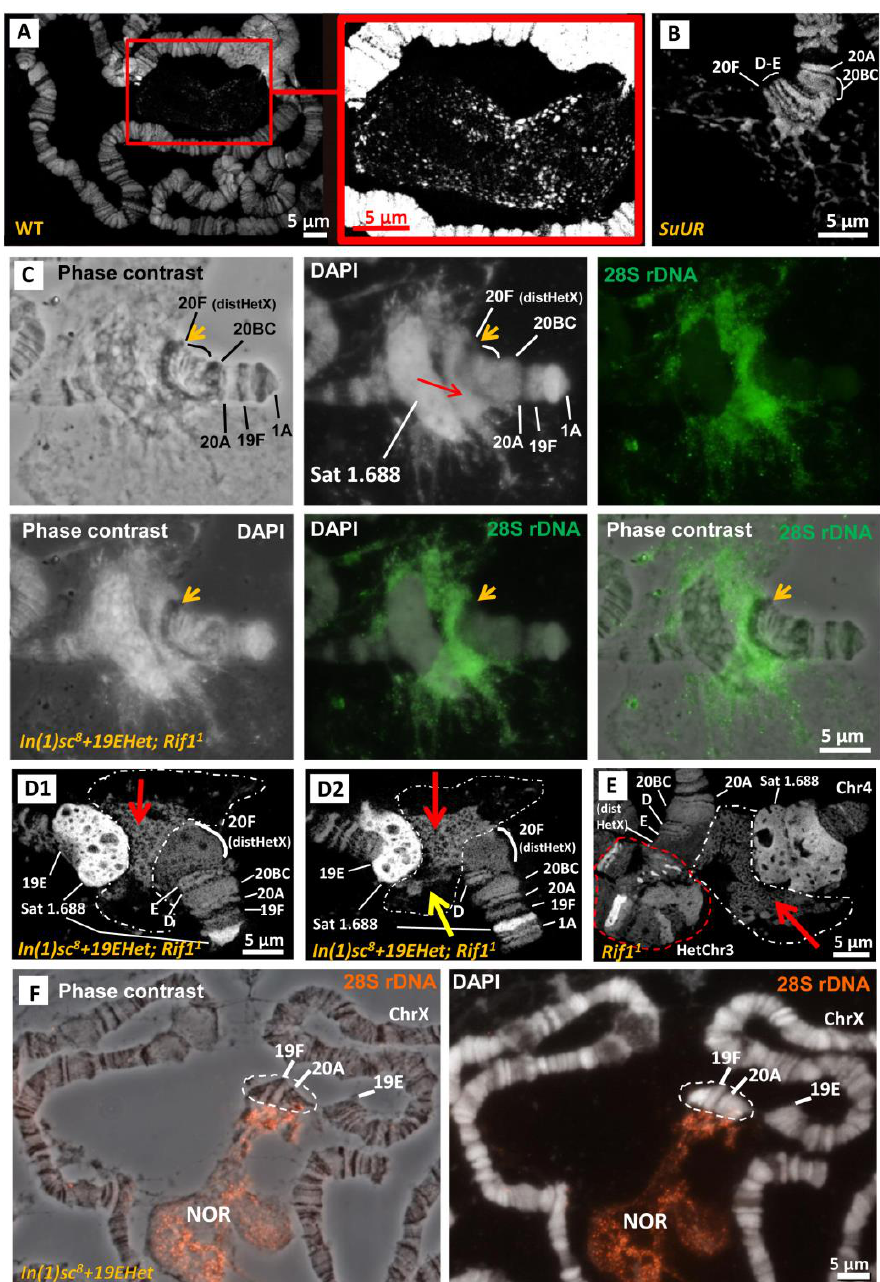
Figure 5. Comparison of the nucleolus morphology in wild-type, SuUR and In(1)sc 8 + 19EHet; Rif1 1 polytene chromosomes. ( A ) DAPI staining with subsequent 3D-SIM microscopy of wild-type polytene chromosomes. The nucleolus is not closely associated with the proximal end of the X chromosome but is connected to the chromocenter and other chromosome regions. The inset shows the nucleolus clearer via overexposure. ( B ) DAPI staining and 3D-SIM of SuUR mutant polytene chromosomes. ( C ) FISH with 28S rDNA probe (green) in In(1)sc 8 + 19EHet ; Rif1 1 polytene chromosomes. Chromosome morphology is shown by phase-contrast imaging and DAPI staining. The red arrow indicates the intrachromosomal rDNA FISH signal. The orange arrow indicates the distal heterochromatin (distHetX) in band 20F poorly stained by DAPI. ( D1 ) DAPI staining and 3D-SIM analysis of In(1)sc 8 + 19EHet ; Rif1 1 chromosomes. The intrachromosomal part of the NO is represented by a spongy structure (indicated by red arrow) located between the block of 1.688 satellite, which is strongly stained by DAPI, and distHetX, which is poorly stained by DAPI. The boundaries of the